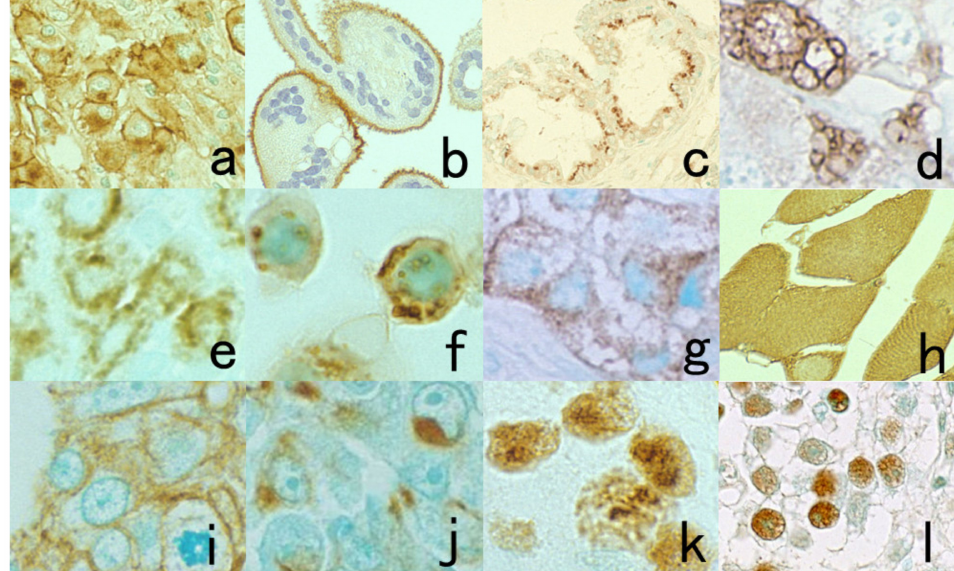
Figure 45. Representative immunohistochemical markers showing various intracellular localization patterns. ( a ): CD30 in anaplastic large cell (Ki-1) lymphoma (plasma membrane plus Golgi area), ( b ): placental ALP on the villi of normal placenta (apical plasma membrane), ( c ): CA125 in ovarian serous adenocarcinoma (mainly seen in the Golgi area), ( d ): IgG in plasmacytoma (coarse vesicles), ( e ): intrinsic factor in parietal cells in the oxyntic gastric mucosa (fine vesicles), ( f ): nonspecific cross- reacting antigen in lysosomes of lung adenocarcinoma cells (cell line PC-9) (coarse granular), ( g ): insulin in pancreatic insulinoma (fine granular), ( h ): creatine kinase-MM isozyme in normal striated muscle (diffuse cytoplasmic), ( i ): cytokeratin in well-differentiated gastric adenocarcinoma (along the plasma membrane), ( j ): cytokeratin in poorly differentiated gastric adenocarcinoma (concentrated in the Golgi area), ( k ): Ki-67 in breast cancer (nucleolar accentuation) and ( l ): proliferating cell nuclear antigen in testicular seminoma (diffuse